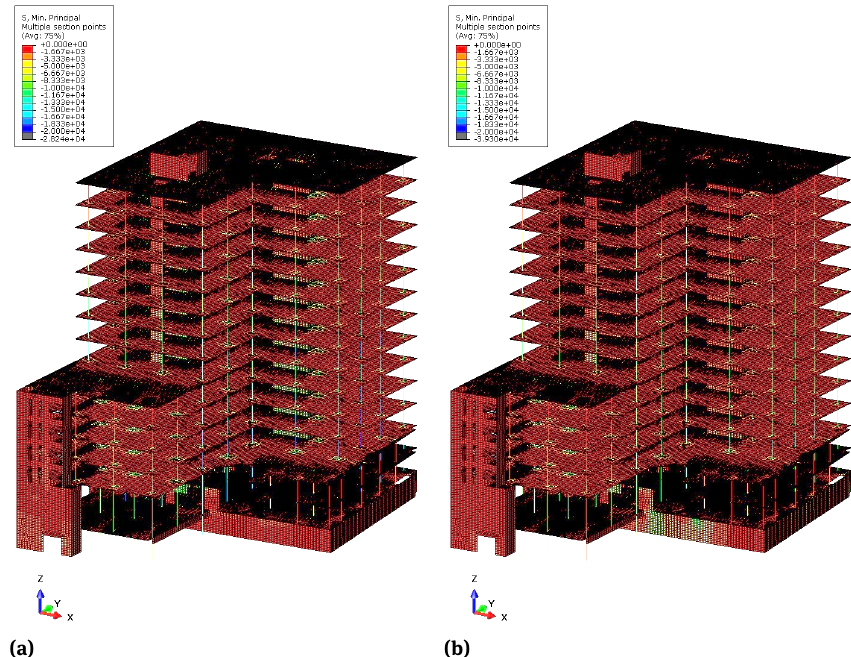
Figure 9: Minimum principal stress [kPa]: a) in model with rigid support, b) in model with subsoil defined by elastico-plastic Cam Clay model